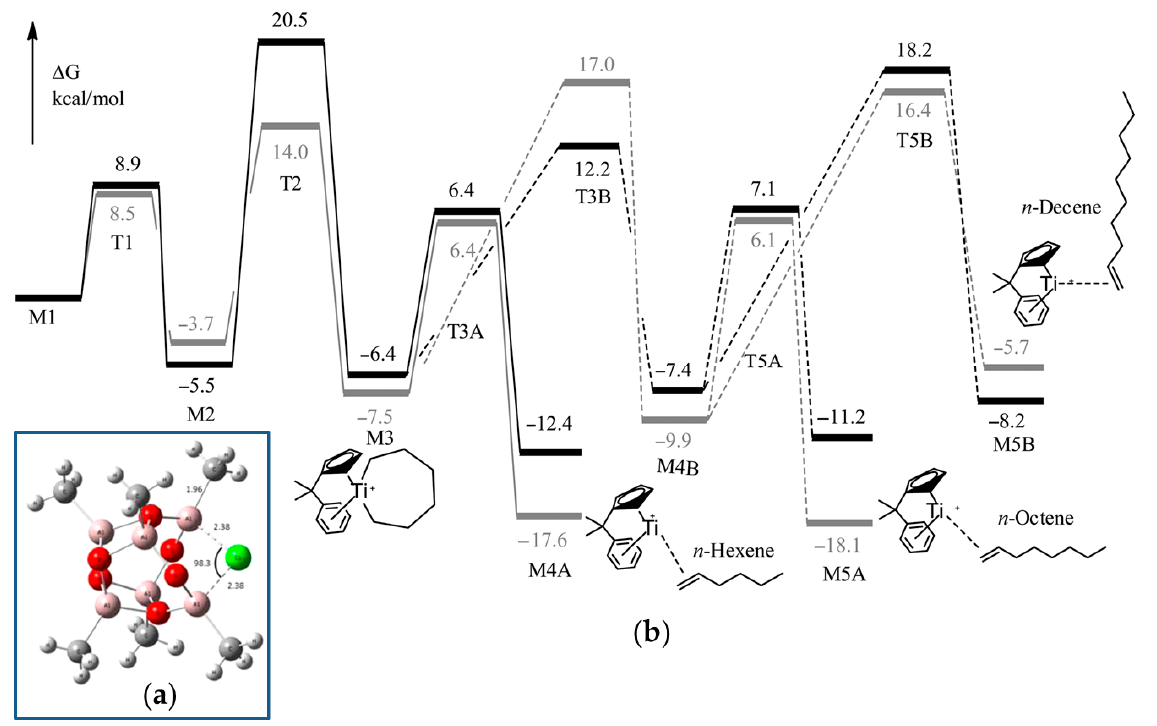
Figure 4. ( a ) B3LYP-optimized configuration of the [MAO-Cl] − anion; ( b ) comparative reaction profile over the potential energy surface for a cationic (gray) and zwitterionic (black) catalyst. The solid line indicates the main path; the dotted line indicates the less favorable alternative path. Reprinted with permission from [83]. Copyright (2015) American Chemical Society.